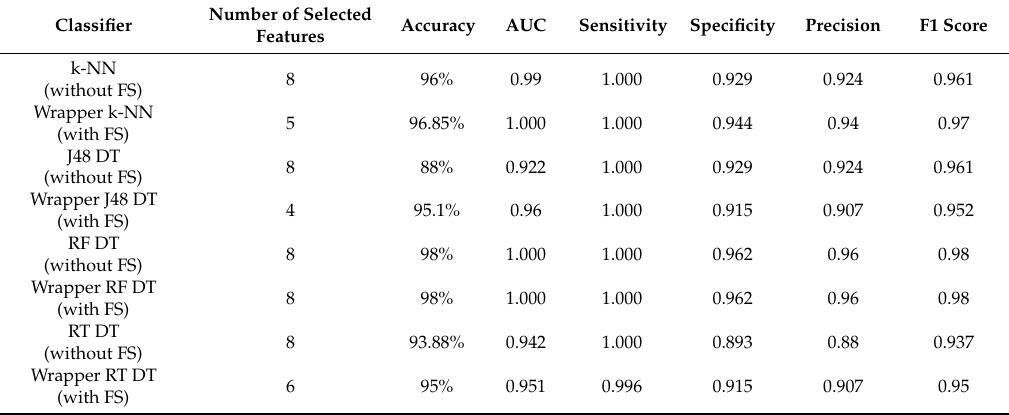
Table 7. The classification results before and after feature selection results using the random search method for the digital mammography dream